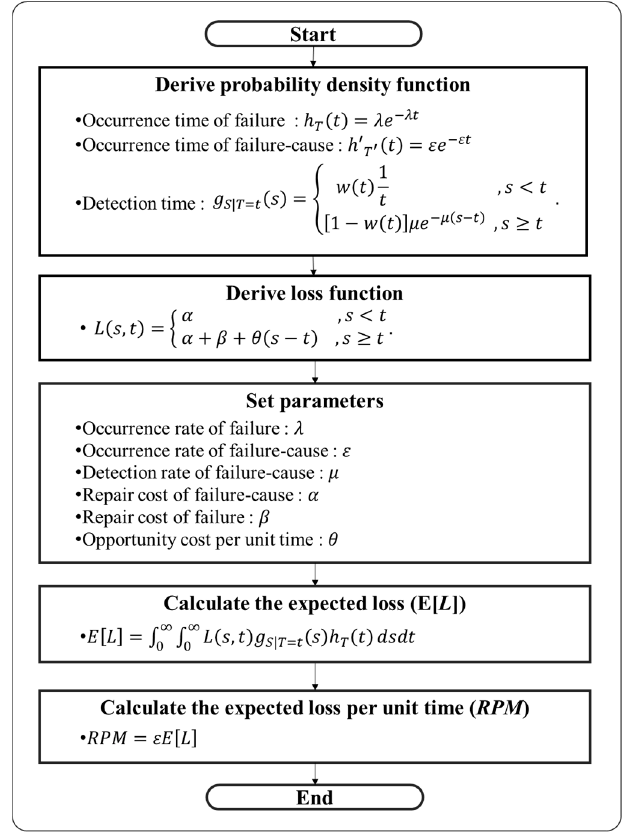
Figure 2. Risk evaluation scheme of time dependent FMEA (TD-FMEA).